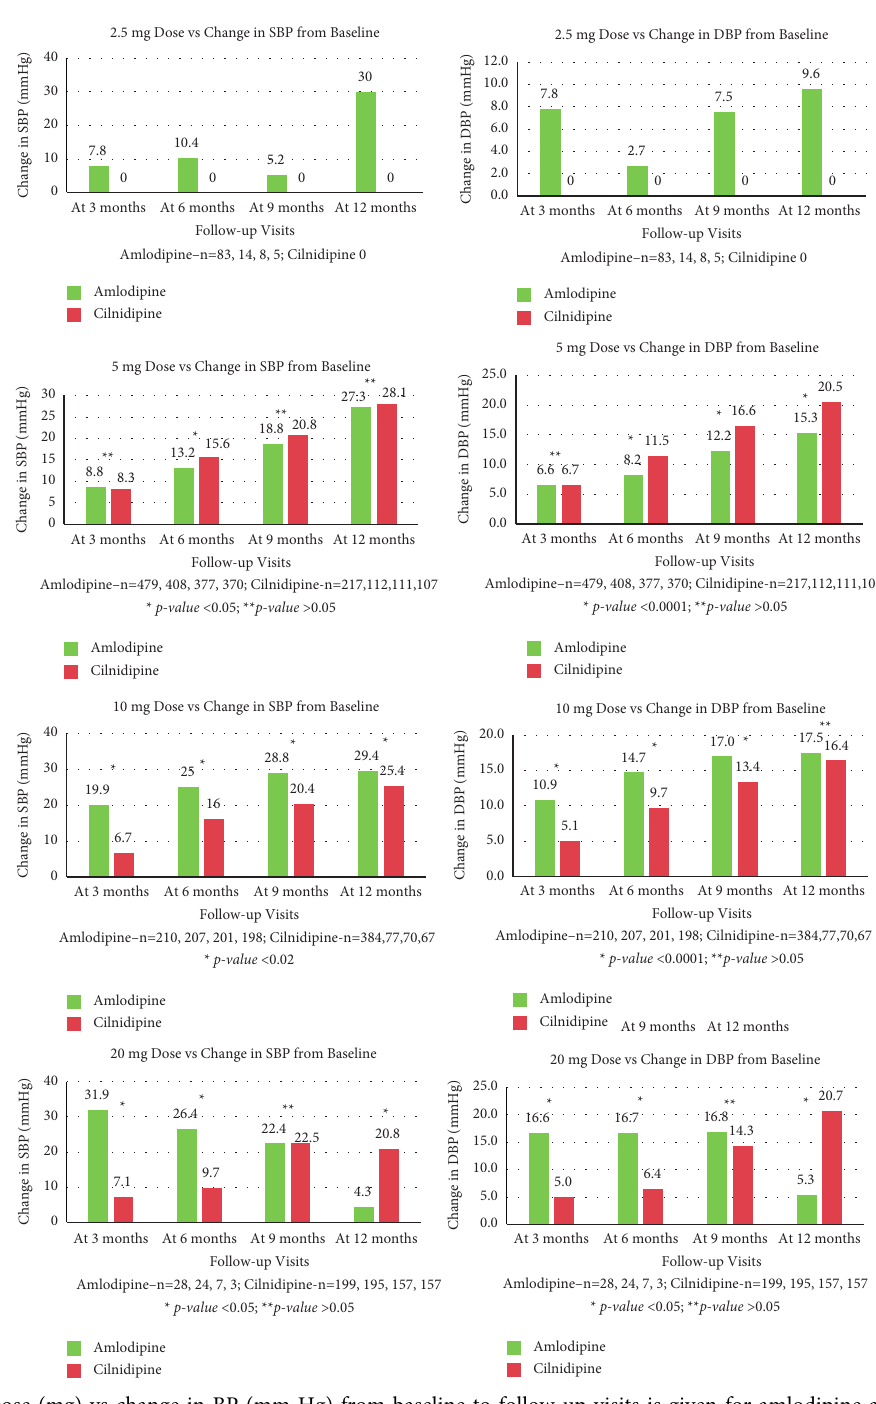
Figure 3: Dose (mg) vs change in BP (mm Hg) from baseline to follow-up visits is given for amlodipine and 28.3 mmHg and DBP by 15.3 mmHg in 12 months of